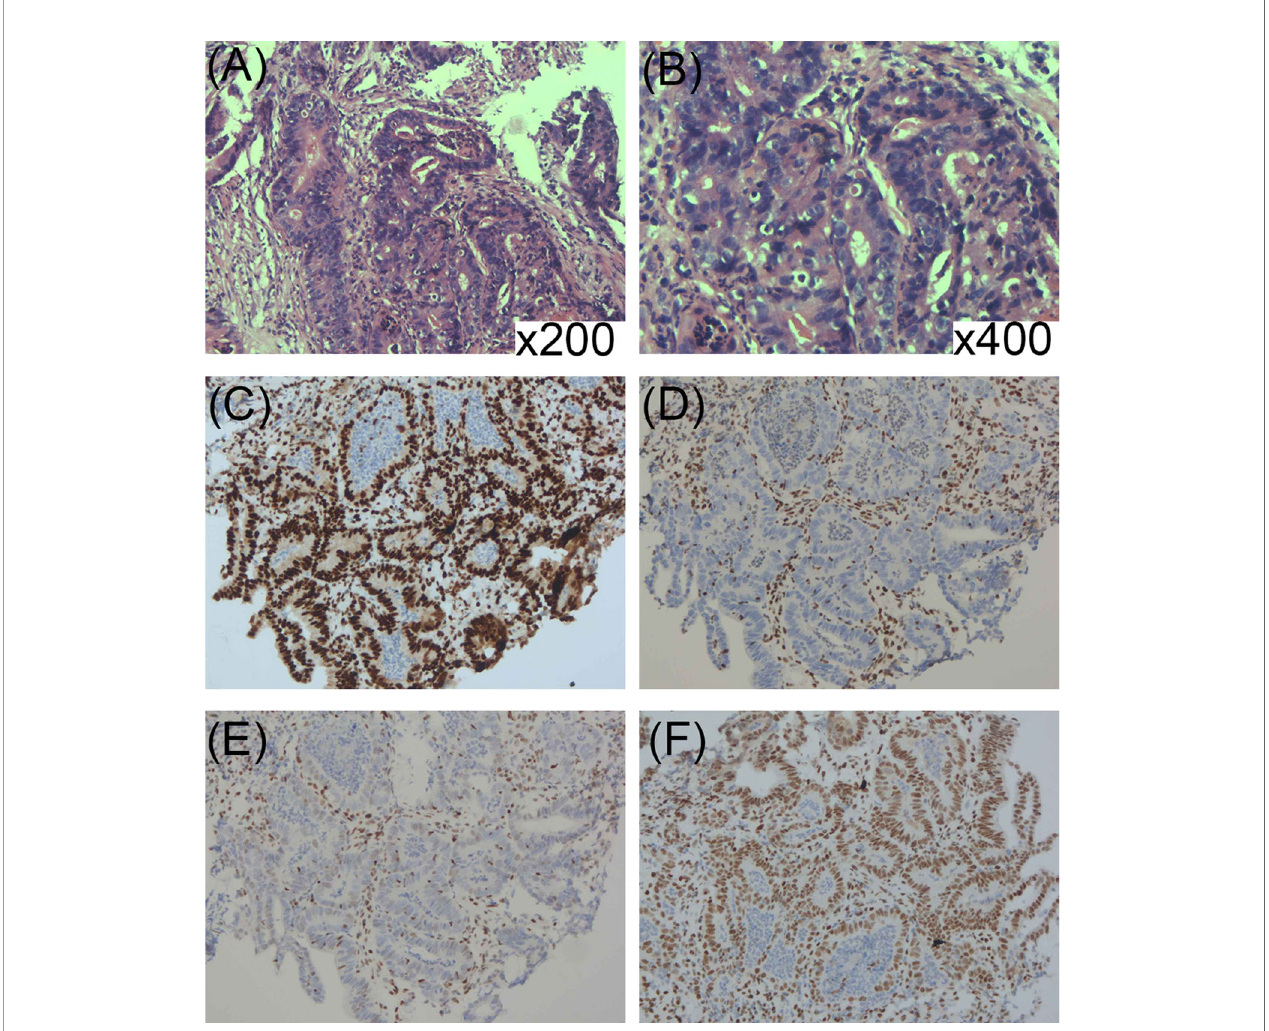
FIGURE 4 | (A, B) Histopathology showed that tumor cells were arranged in columnar and glandular tubular shape, with obvious cellular atypia as well as interstitial and muscularis mucosae in fi ltrate (HE ×200; ×400). (C – F) Immunohistochemical staining for DNA mismatch repair-related proteins (MMR proteins MLH1, MSH2, MSH6, and PMS2) of the sigmoid adenocarcinoma: (C) Normal nuclear expression of MLH1 protein. (D) Lack of nuclear expression of MSH2 protein. (E) Lack of nuclear expression of MSH6 protein. (F) Normal nuclear expression of PMS2